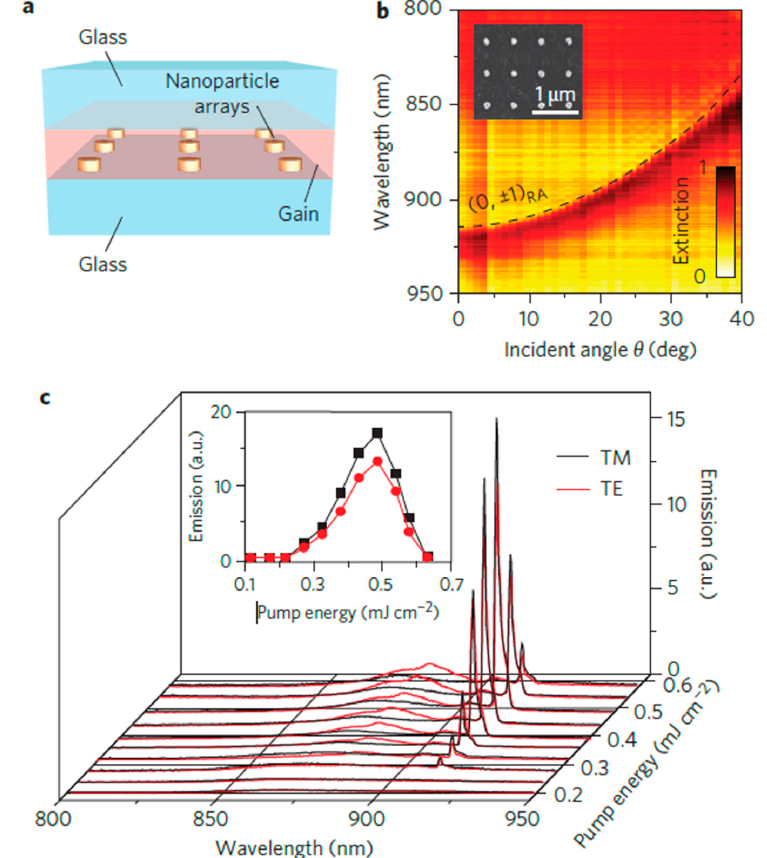
Figure 9. Lasing in nanoparticle arrays. ( a ) Schematic of a nanoparticle array laser. ( b ) Measured extinction spectra as a function of incident angle θ for a two-dimensional Au nanoparticle array (inset) under transverse-magnetic (TM) illumination. ( c ) Spectra of light emitted normal to the nanoparticle array for different pump energies. Pulsed laser light of 800 nm wavelength was used to pump the sample array with an IR-140 dye gain medium at an incident angle of 45° . Adapted with permission from ref [95], Springer Nature.